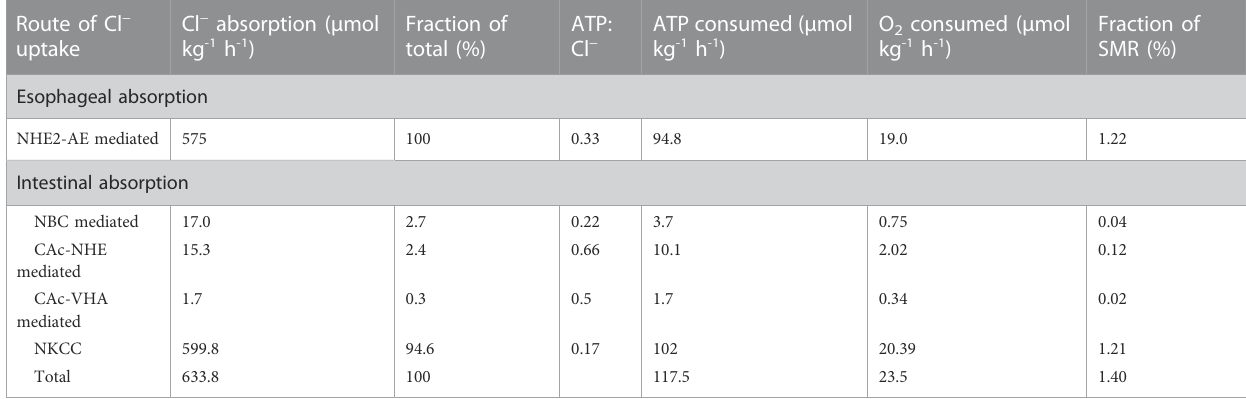
TABLE 1 Esophageal and intestinal ion transport pathways and their contribution to Cl − uptake, ATP and O 2 consumption as well as their relative contribution to standard metabolic rate (SMR). See text for further detail. Route of Cl −